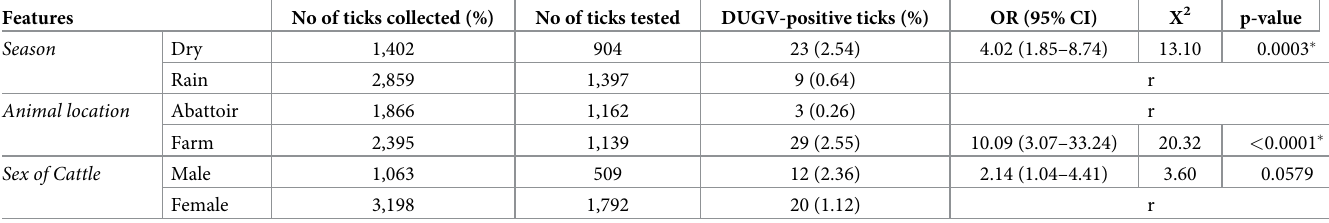
Table 4. Distribution of DUGV-positive A . variegatum based on season, sex and location of cattle harboring ticks in Kwara State, Nigeria.